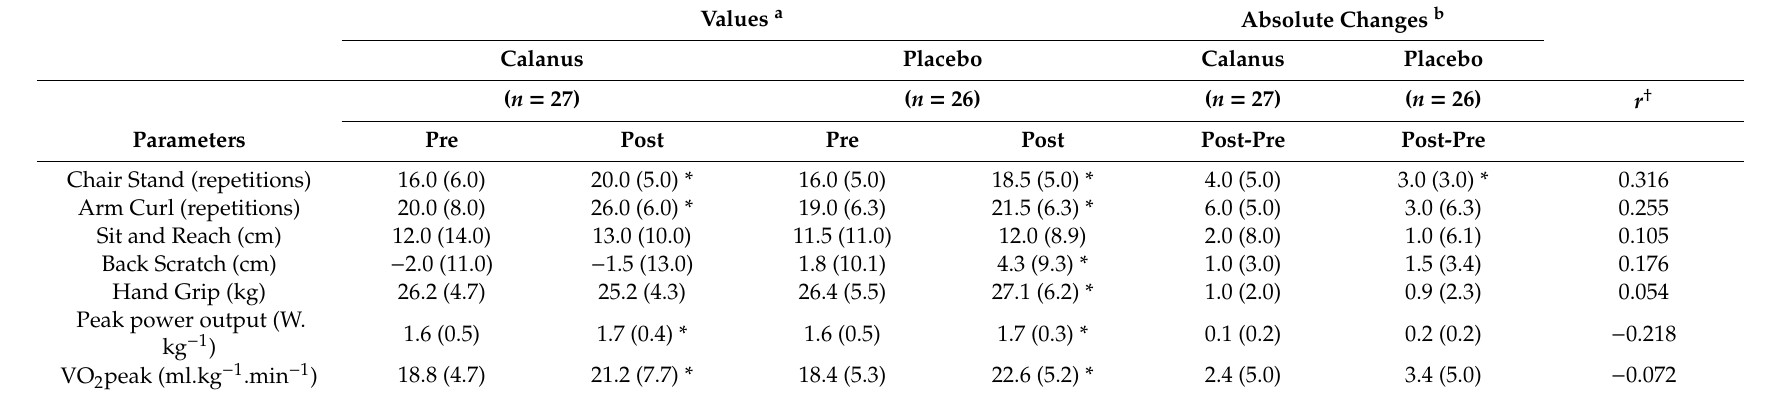
Table 2. Comparison of physical performance within groups and between groups.